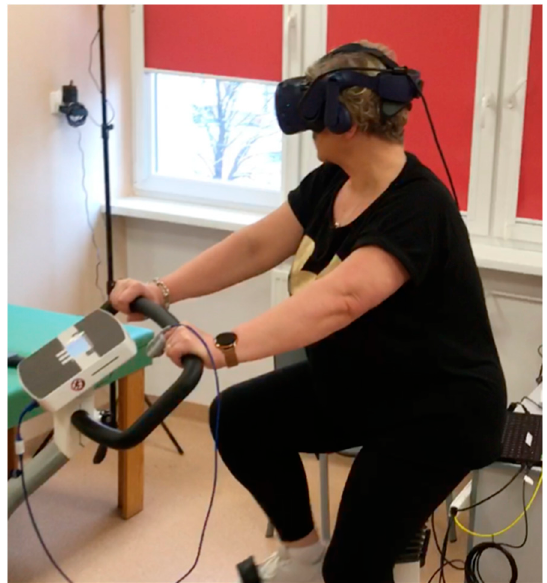
Figure 3. Exercise training in VR.